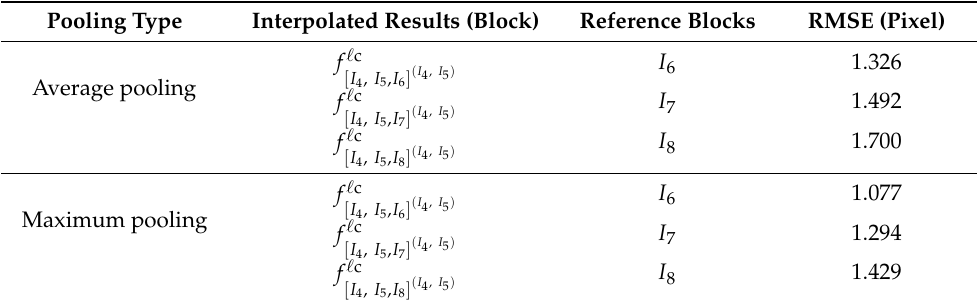
Table 7. Quantitative evaluation between block interpolated result and reference block using different pooling types.